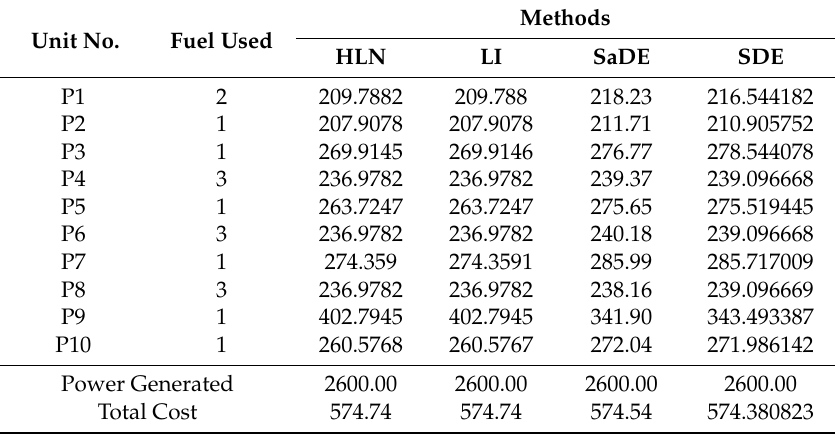
Table 2. Cost comparison among various methodologies for System 1, P d = 2600 MW.